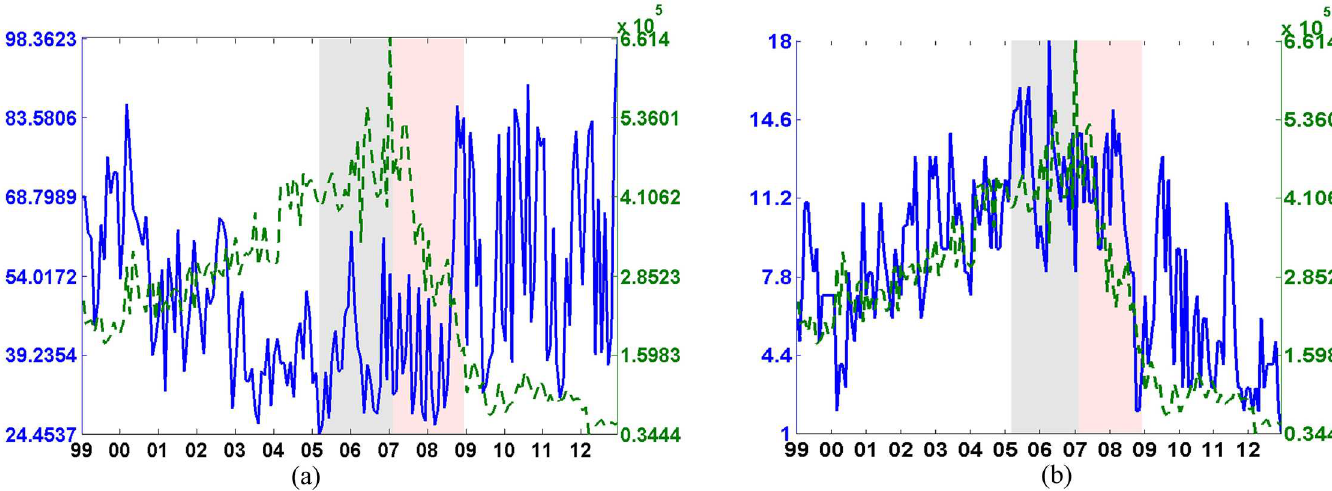
Fig 2. Traded volume (a) and number of communities (b). Time evolutionof the model fit (blue line) versus the traded volume (green dashed line) is shown in the panel (a). Panel (b) displaysthe number of communities (blue line) versus the traded volume (dashedgreen line). The x-axis displaysthe time evolution. The y-right axis displaysthe traded volume in millionsof dollars while on the y-left axis we report the model fitting (left panel), and the number of communities(right